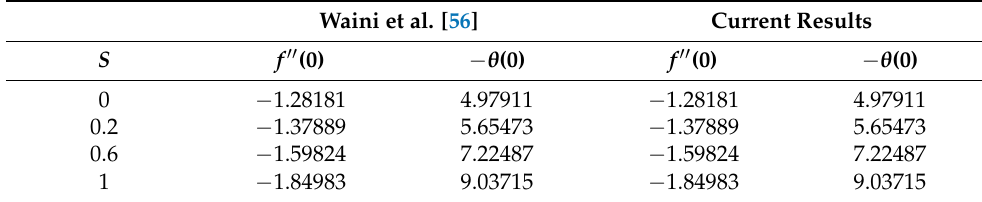
Table 3. Magnitude of f (cid:48)(cid:48) (0) and − θ (0) under various estimates of S . Waini et al. [56] Current Results